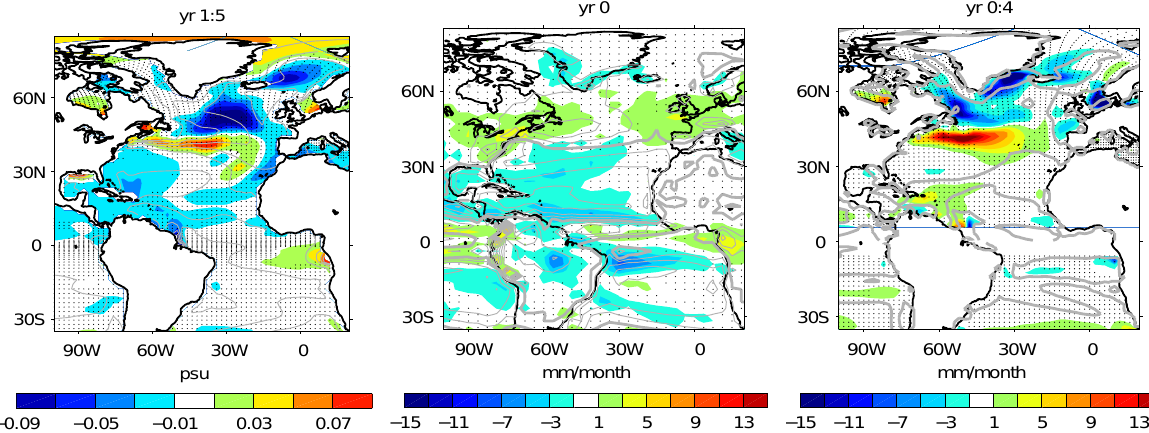
Fig. 14. Top: Composites of anomalous SSS averaged 1 to 5 years after the eruption. Grey lines show the annual mean SSS field in the model, with a contour interval of 2 psu. Middle: Composite of anomalous E-P during the year of the eruption. Bottom: composite of advection of mean salinity by anomalous Ekman currents (with a negative sign in order to be consistent with the E-P forcing term) averaged over the 4 years following the eruption. Values equatorward of 10 ◦ latitude are masked because undefined. All composite are computed for eruptions occurring later than 1400 A.D. For the two right panels, grey lines show the annual mean field in the model with a contour interval of 40mm/month. The zero contour is thicker. For all panels, dotted areas are not significant at the 5%